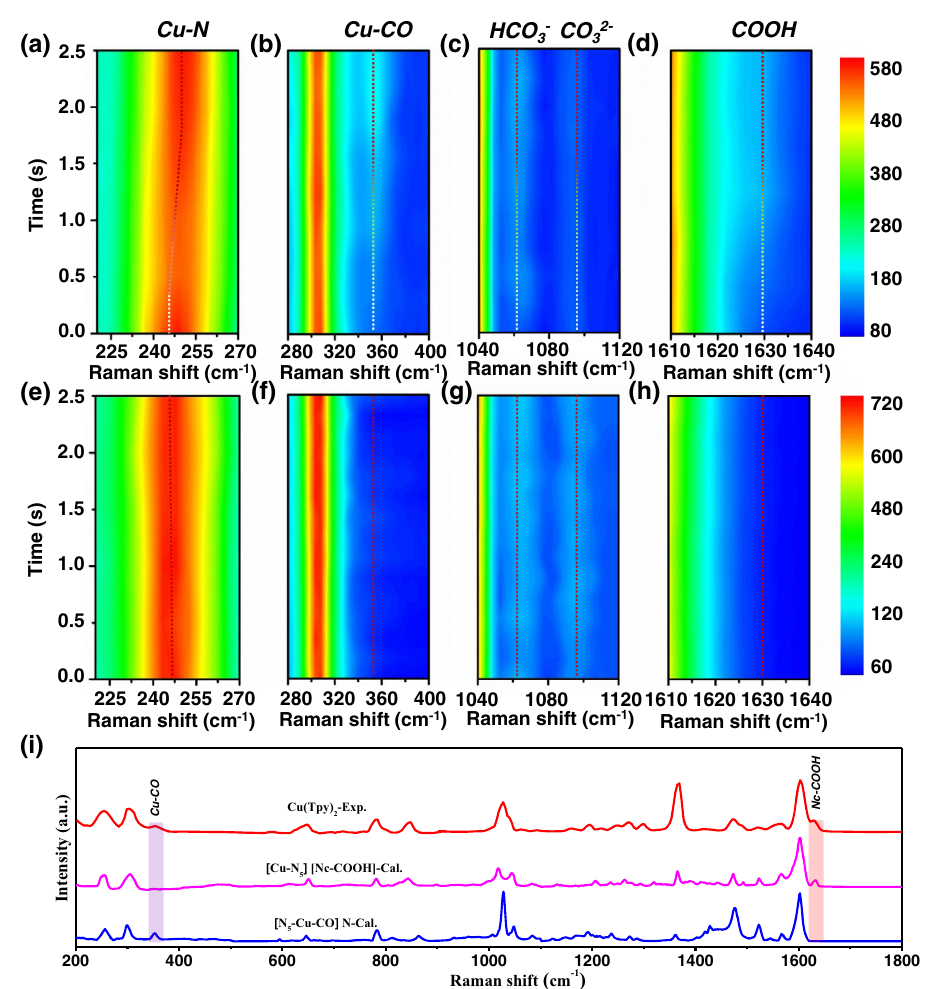
Fig. 3 | Time-dependent operando Raman spectra of Cu(Tpy)2-KB@GC under electrocatalytic conditions. The spectra were measured using ( a – d ) a CO 2 -satu- rated 0.5M KHCO 3 solution and ( e – h ) an Ar-saturated 0.5M KHCO 3 solution, respectively. The potential was controlled at − 0.45V vs. RHE. The results are